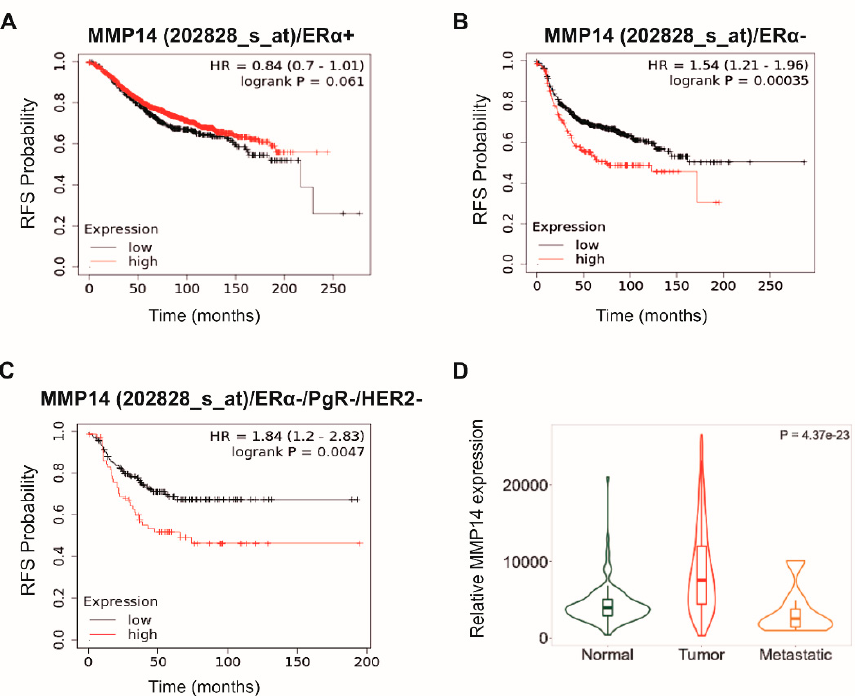
Figure 1. Prognostic and therapeutic value of MMP14 expression using meta-analysis tools. ( A – C ) Kaplan–Meier survival analysis of relapse-free survival (RFS) probability in different breast cancer patient datasets after diagnosis using gene chip data from GEO, EGA, TCGA databases. MMP14 (MT1-MMP) expression ( A ) is correlated to better prognosis in ER α -positive (ER α +) breast cancer patients following systemic treatment compared to ER α -negative (ER α -) patients ( B ) and triple-negative breast cancer patients ( C ). p value and hazard ratio (HR) value were calculated using a log-rank test [33]. ( D ) MMP14 gene expression profile of normal mammary tissues, breast invasive carcinoma and metastatic breast tissues, mining RNA-seq and gene chip data from GEO, GTEx, TCGA and TARGET databases, and presented as violin plot. Normal tissue N = 242, Tumor N = 7569, Metastatic N = 82. Abbreviations: EGA, European genome-phenome archive; GEO, gene expression omnibus; GTEx, genotype-tissue expression; TARGET, tumor alterations relevant for genomics-driven therapy; TCGA, the cancer genome atlas.